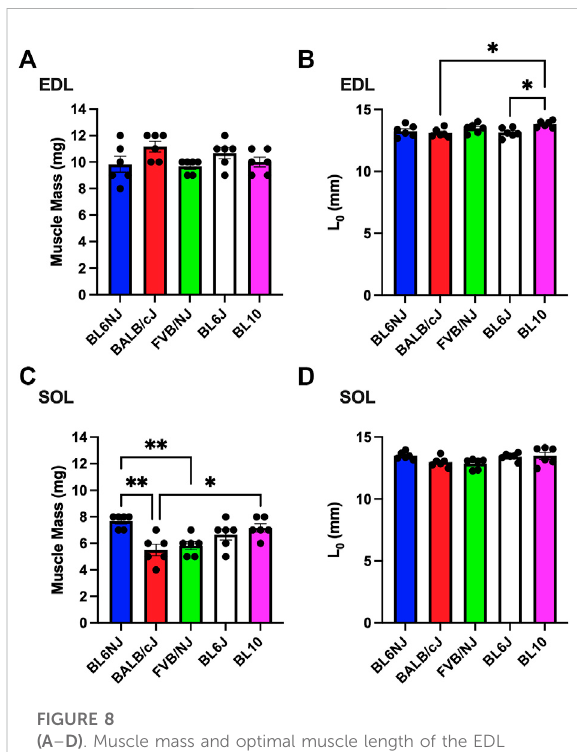
FIGURE 8 (A – D) . Muscle mass and optimal muscle length of the EDL (A,B) and soleus muscle (C,D) from various strains of mice. Statistically signi fi cant difference is indicated by one symbol = p < 0.05; two symbols = p <